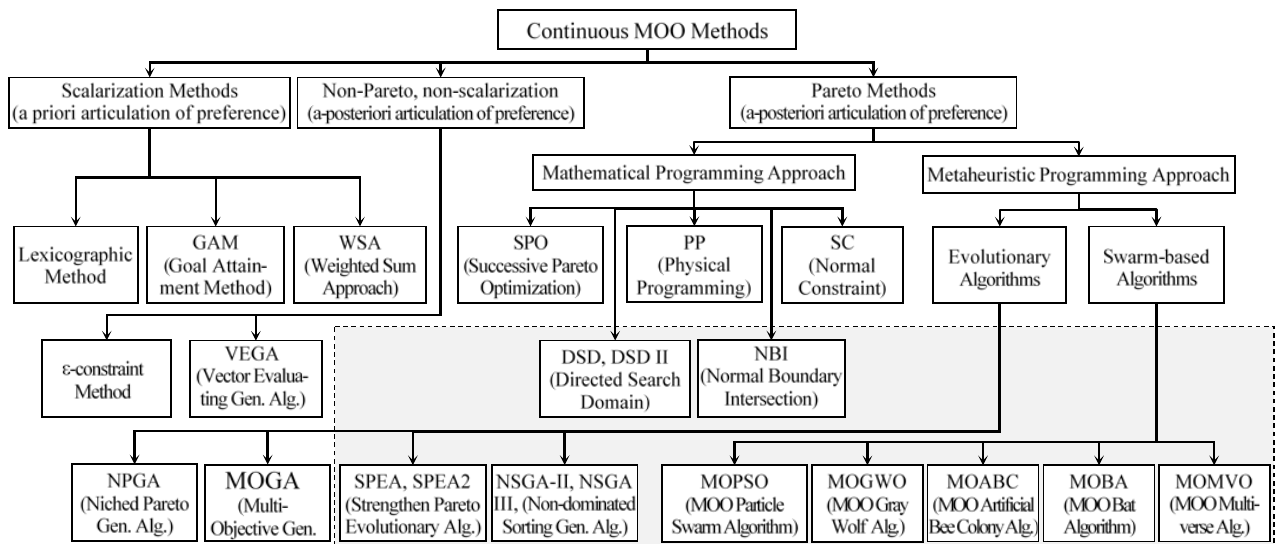
Figure 2. Classification of most important multiobjective optimal (MOO) algorithms (algorithms inside doted gray box are included in numerical study). © [2020] IEEE. Reprinted, with permission, from [10].